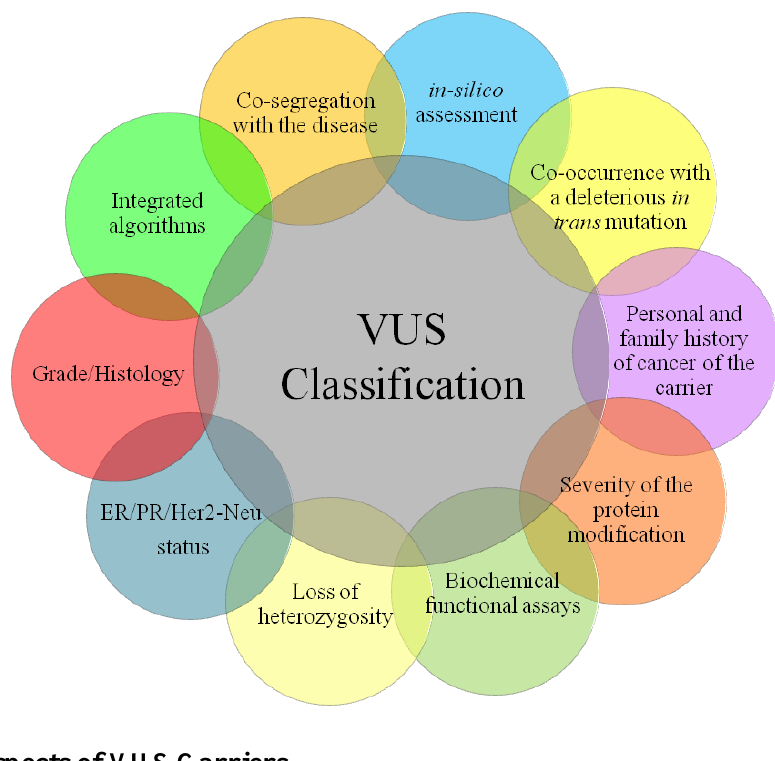
Figure 1. A representation of the multi-determinant approach to use for BRCA -VUS clinical